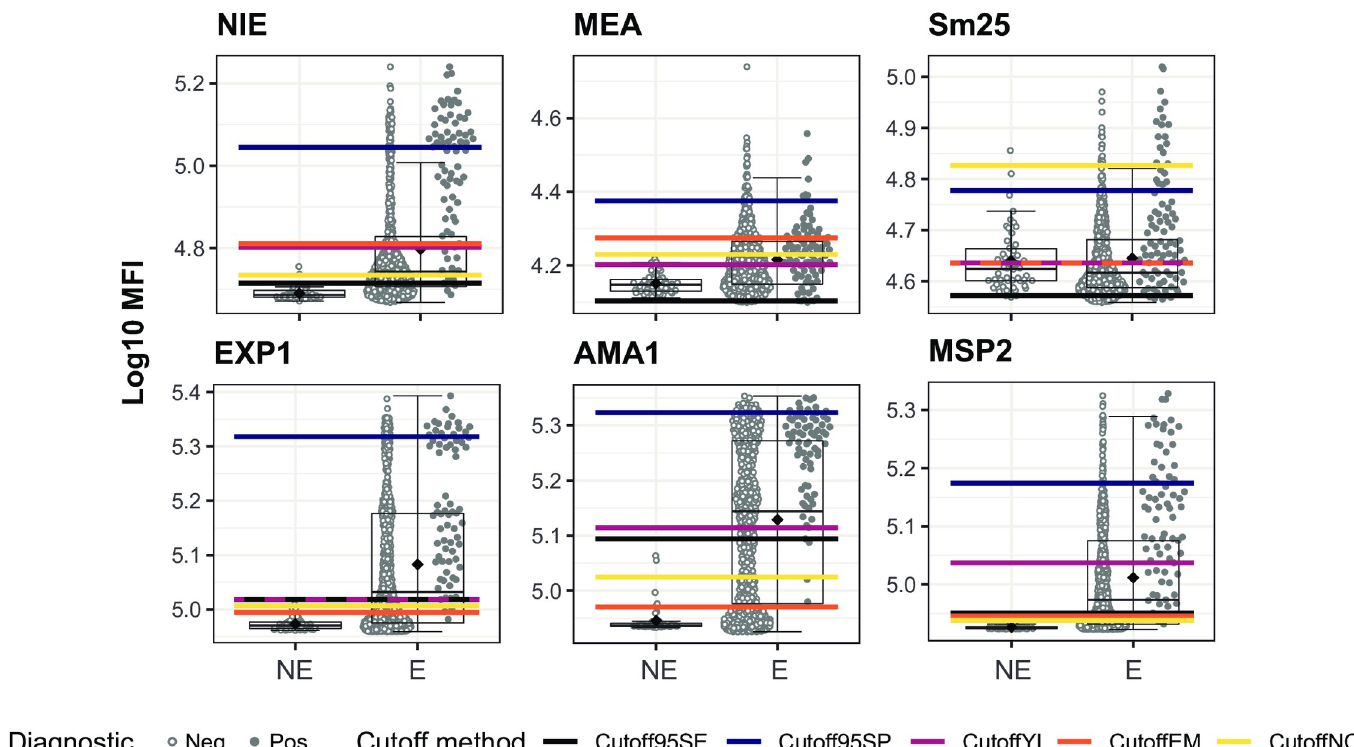
Fig 7. Helminth and Plasmodium falciparum antigen-specific IgG levels in non-endemic and endemic populations and seropositivity cutoffs calculated by different methods. Antibody levels are presented as the log 10 -transformed median fluorescence intensity (MFI) of IgG against Strongyloides stercoralis (NIE), Schistosoma spp. (Sm25 and MEA) and P . falciparum (EXP1, AMA1 and MSP2) antigens. In the endemic population, filled dots highlight individuals with a helminth infection with the corresponding parasite for each antigen detected by microscopy and/or qPCR in the case of helminths and qPCR in the case of P . falciparum . The boxplots represent the median (bold line), the mean (black diamond), the first and third quartiles (box) and the largest and smallest values within 1.5 times the interquartile range (whiskers). Data beyond the end of the whiskers are outliers. Cutoff95SE: cutoff prioritizing a minimum sensitivity of 95%; Cutoff95SP: cutoff prioritizing a minimum specificity of 95%; CutoffYI: cutoff corresponding to the maximum Youden’s Index; CutoffEM: cutoff defined by the Expectation-Maximization algorithm; CutoffNC: cutoff calculated as mean + 3 � standard deviations of the log 10 -transformed MFI levels from the non-endemic population. NE: Non-Endemic (N = 50), E: Endemic (N = 715). The rest of the antigens are in S2 and S3